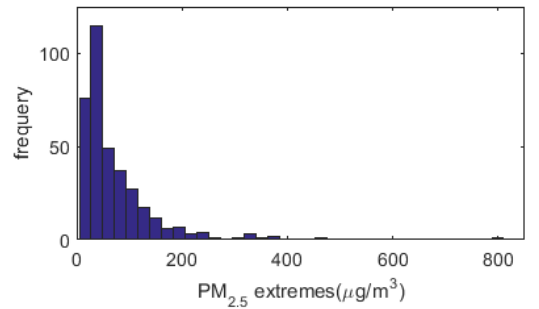
Figure 3. The histogram of hourly PM 2.5 extremes at one representative station of Zhangjiakou in